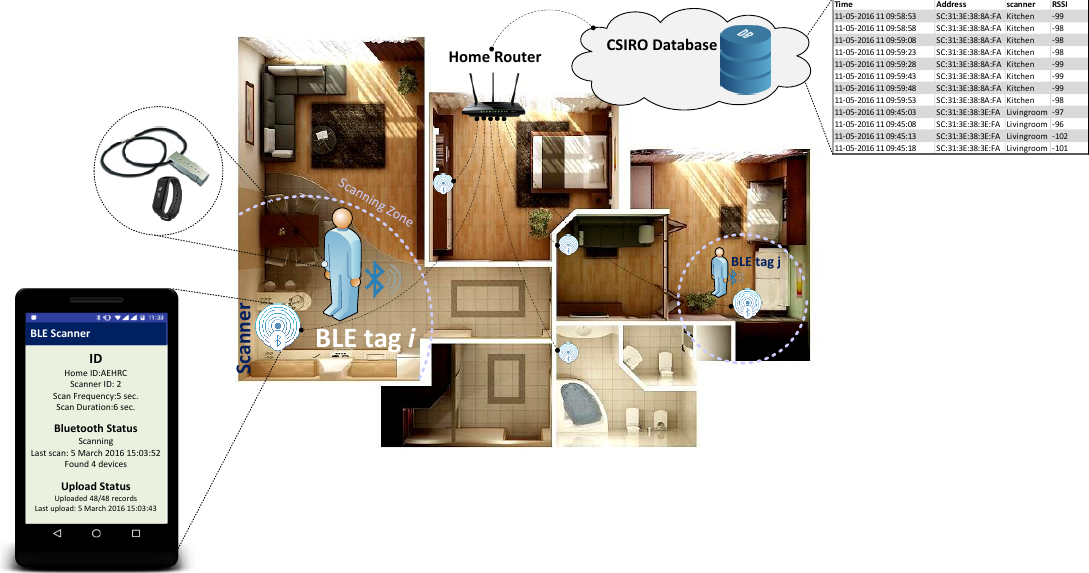
1. using Bluetooth low setup for Figure 1. Implemented setup for multi-resident localization using Bluetooth low energy (BLE) technology. energy (BLE) technology. energy (BLE) technology. energy (BLE) technology.